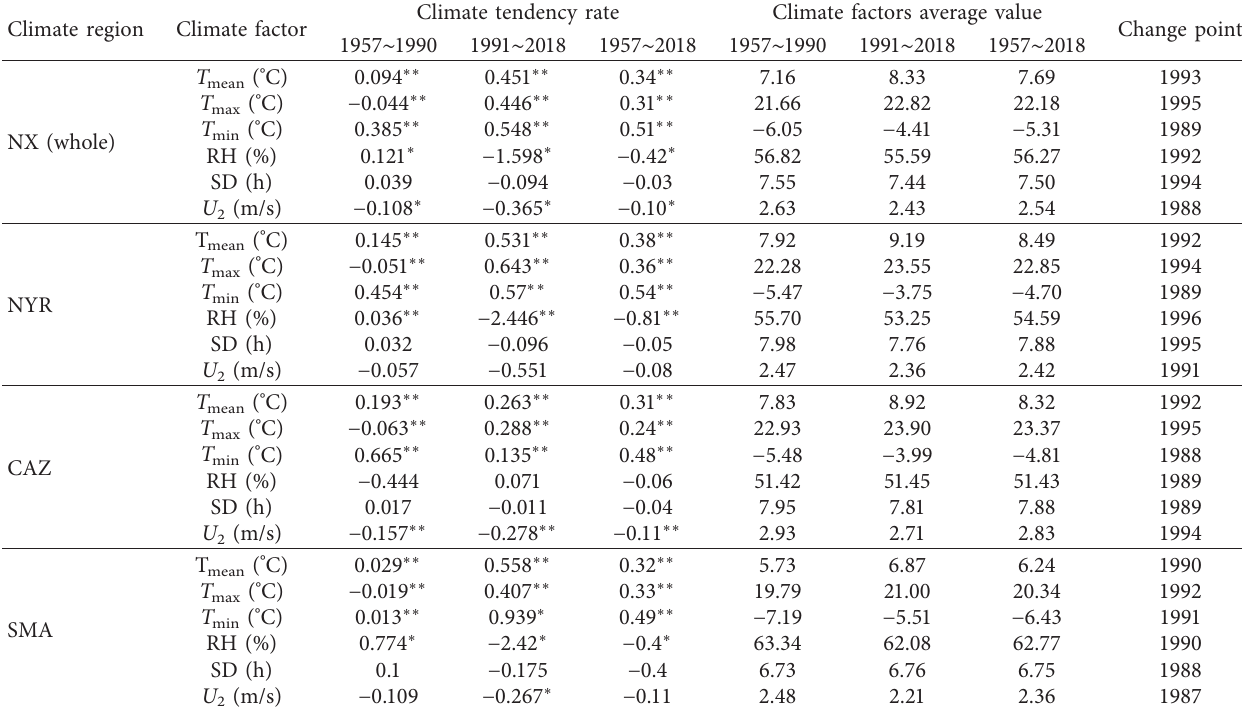
Table 2: Trend analyses of climate factors with Mann–Kendall test and climate tendency